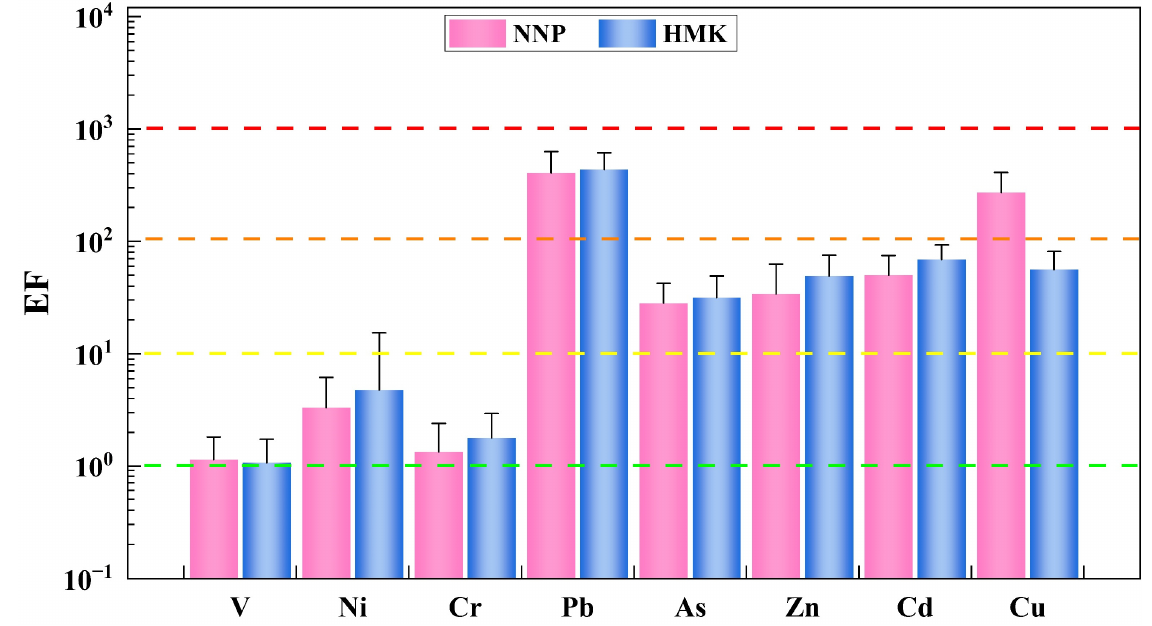
Figure 9. Enrichment factors (EFs) of PTEs in PM 1